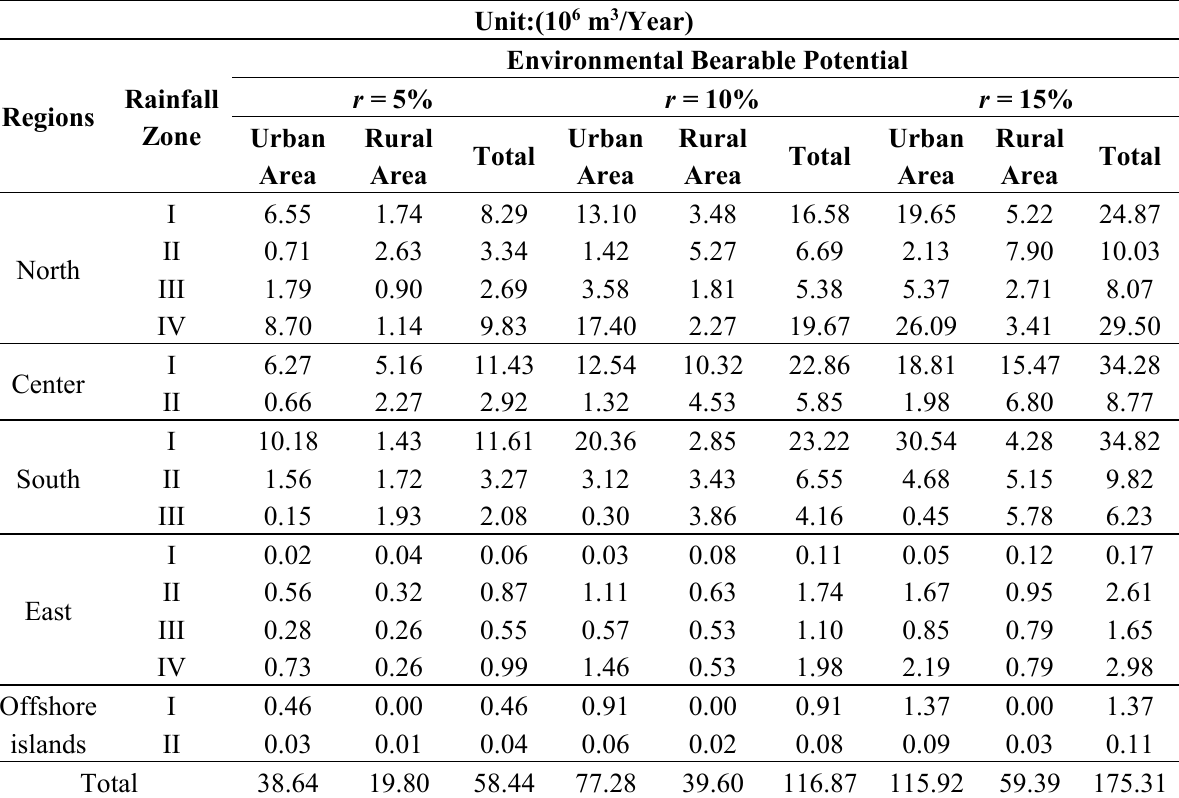
Table 7. Environmental bearable rainwater potential for selected percentages of total roof area in different regions and rainfall